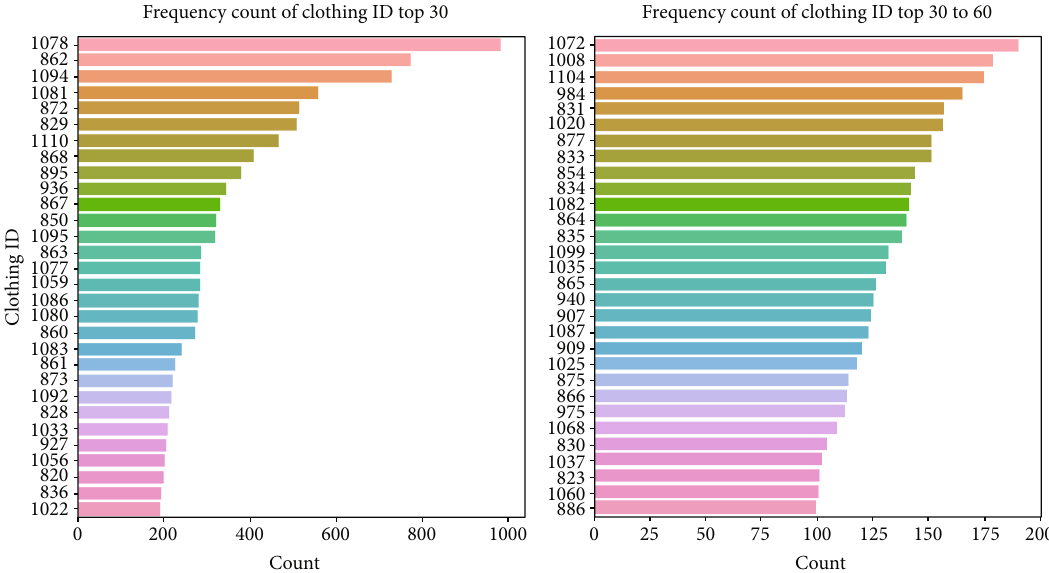
Figure 3: Clothing IDs among the top 60 e-commerce apparel reviews.